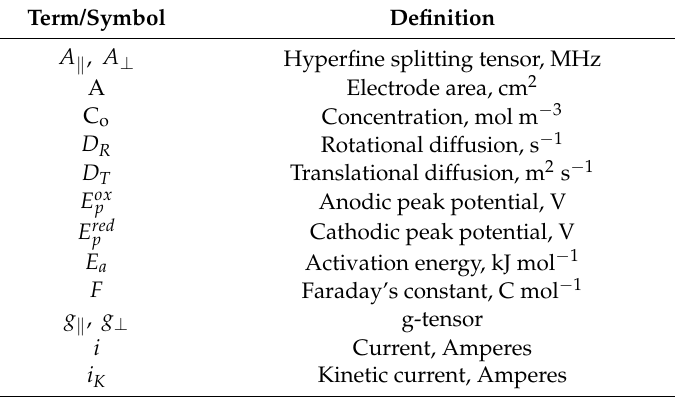
Table A1. List of terms and